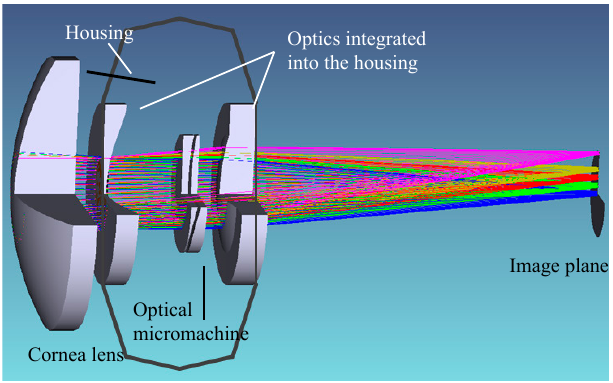
Figure 9. Model of the demonstrator optics of the AAS: Cornea lens, sketch of the housing with the integrated optics, the optical micromachine, and the image plane [29].